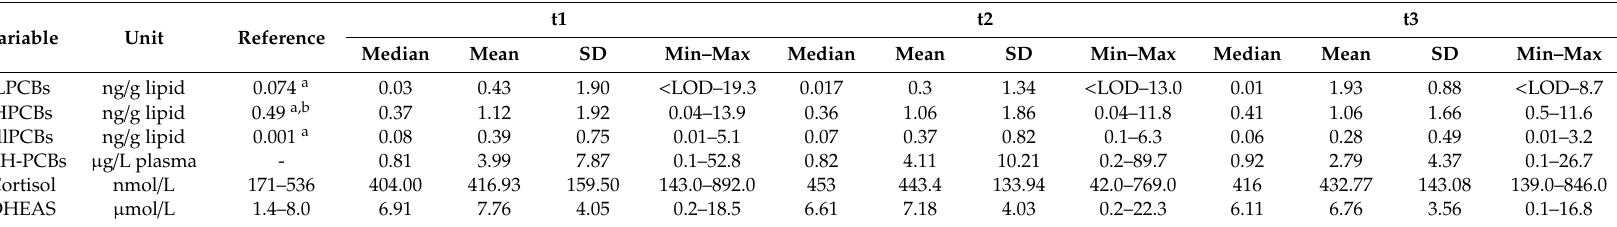
Table 1. Descriptive data of PCBs and stress hormones ( N =